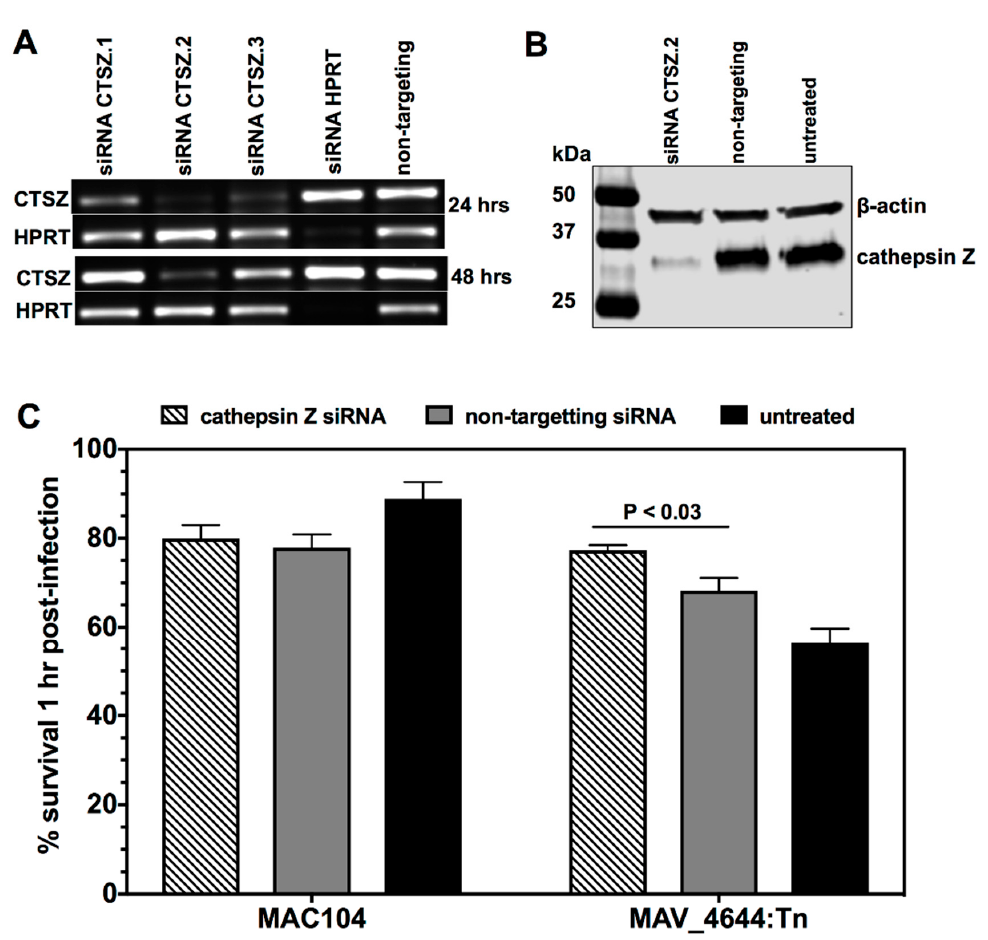
Figure 7. ( A ) Comparison of the CTSZ gene expression levels in THP-1 macrophages. The values are expressed as the number of cDNA copies detected by quantitative RT-PCR in samples obtained from 24 and 48 h transfected macrophages with Viromer ® GREEN transfection reagent (Lipocalyx). Three di ff erent CTSZ-targeting siRNAs were tested separately to identify the most e ff ective targeting siRNA. The housekeeping gene hypoxanthine-guanine phosphoribosyltransferase (HPRT)